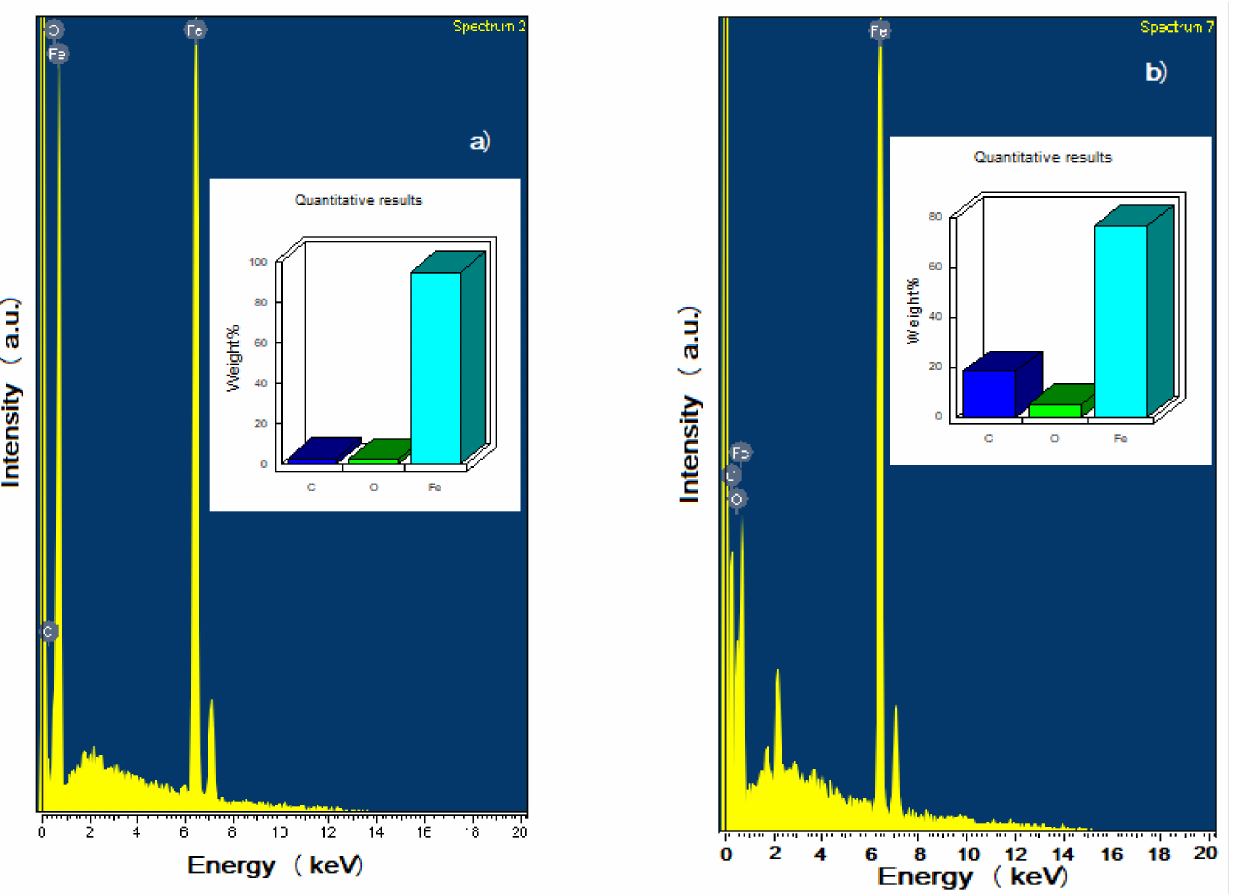
Figure 10. EDX micro chemical analysis of corrosion products formed on top of steel corroding in solution containing ( a ) 0 and ( b ) 100 ppm of gemini